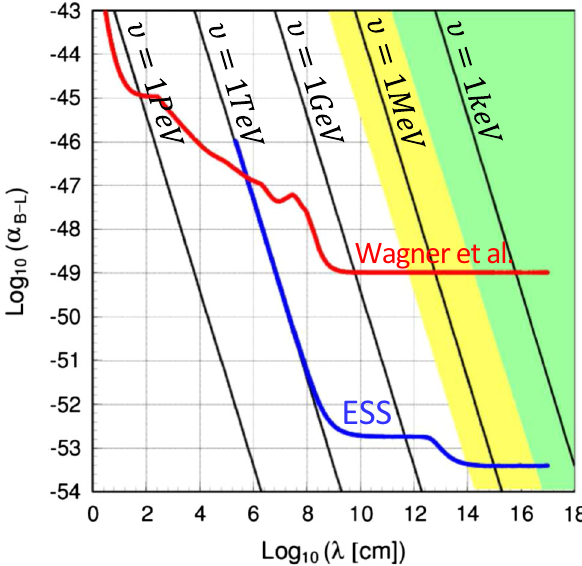
Fig. 1 Limits on α B − L as a function of the Yukawa radius λ . Region above the red curve is experimentally excluded by the results of Wagner et al. [34]. The correlation between α B − L and λ of Eq. (10) for different values of U ( 1 ) B − L breaking VEV v are shown for the sake of demon- stration of the possible scale of the mechanism. Light and dark shaded regions are excluded by the nuclear stability limits, Eq. (15), respec- tively, for ε n ˜ n > 2 . 5 × 10 − 24 eV and ε n ˜ n > 10 − 26 eV. The region above the blue curve can be excluded if the ESS experiment will discover n – ˜ n mixing at the level ε n ˜ n > 10 − 25 eV (see Sect.